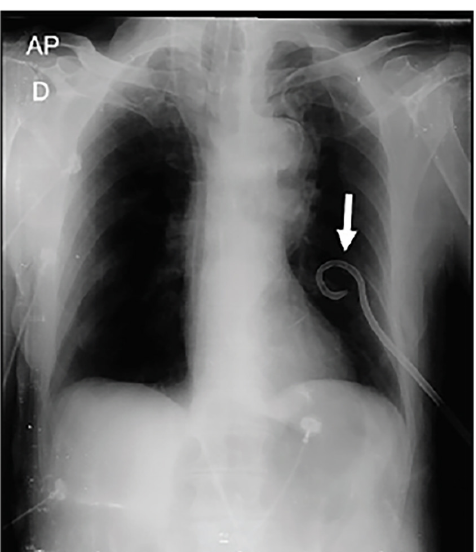
Image 1. Chest radiograph: well-positioned catheter and good lung expansion